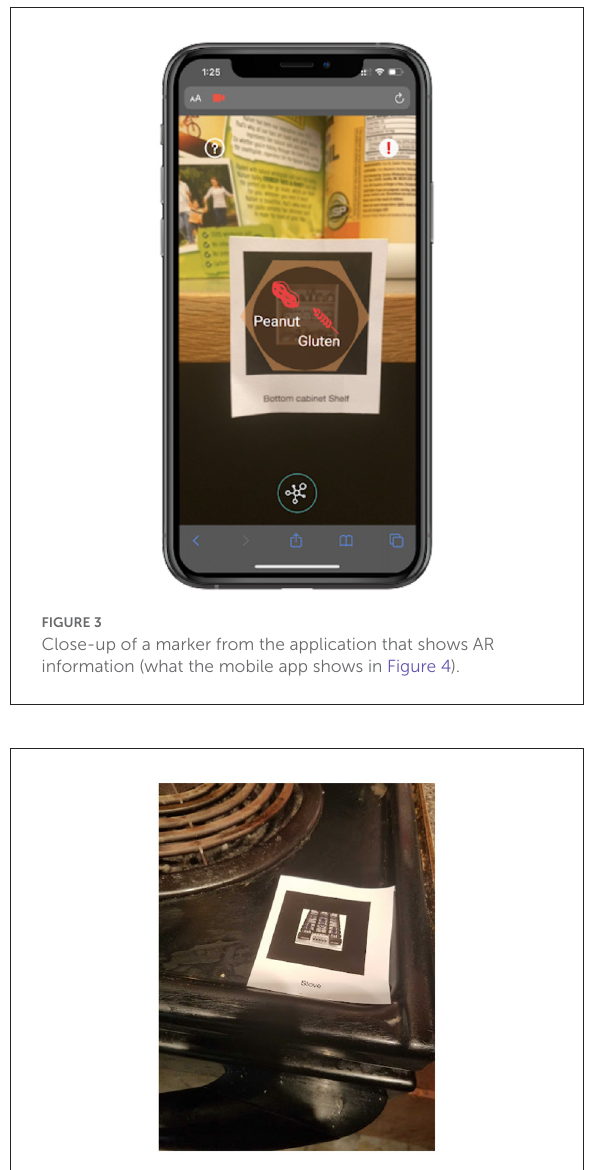
FIGURE4 Close-up of a marker (circled in red on Figure 2).